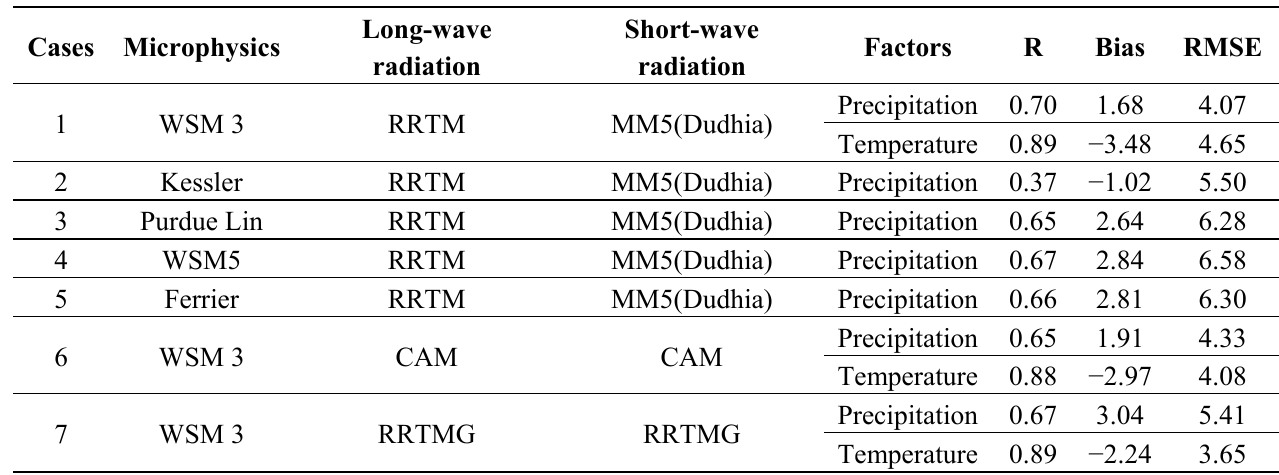
Table 1. Descriptive statistics of precipitation and temperature from WRF/SSiB